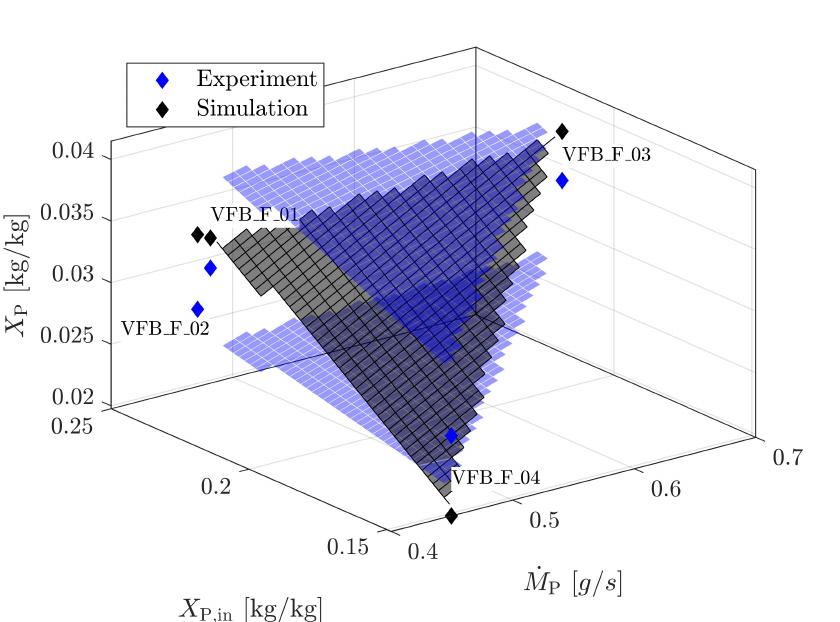
Figure 15. Comparison of measurements and model predictions of particle moisture content ( X P ), plotted against particle mass flow ( ˙ M P,in ) and particle inlet moisture content ( X P,in ), in the VFB pilot-plant-scale dryer for FCC catalyst. The dark gray area designates model predictions; light blue areas indicate the upper and lower boundary of measurement errors. Detailed information about the process conditions of the represented data points is given in Table 2.